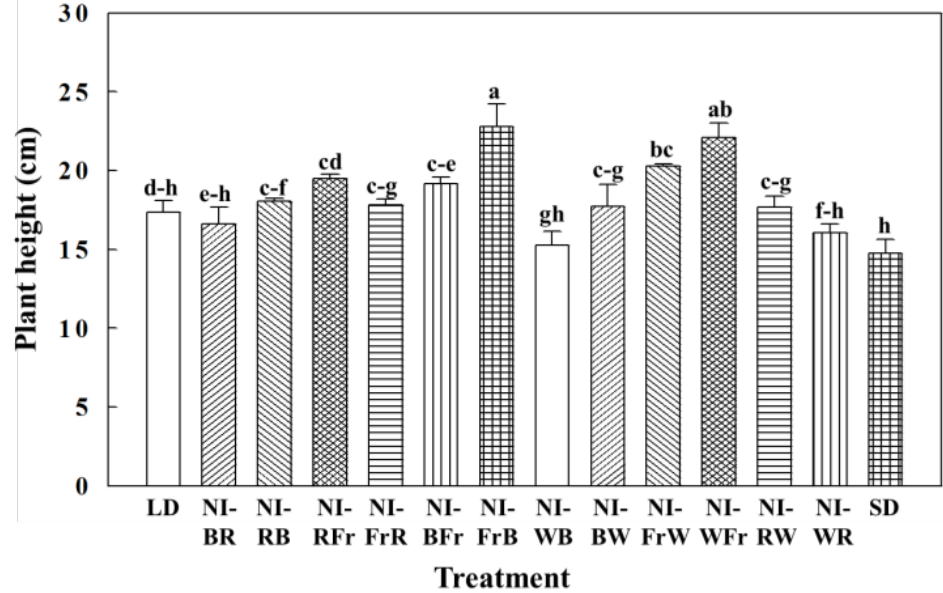
Figure 2. Effects of 10 µ mol · m − 2 · s − 1 PPFD night-interruption light (NIL) quality shifting on the plant height of geranium ( Pelargonium × hortorum L.H. Bailey ‘Ringo 2000 Violet’) measured 40 days after treatment. Please refer to Figure 1 for detailed NIL qualities. Means accompanied by different letters are significantly different ( p < 0.05) according to the Duncan’s multiple range test at 5% significance level. Vertical bars are means ± S.E. (n = 3).